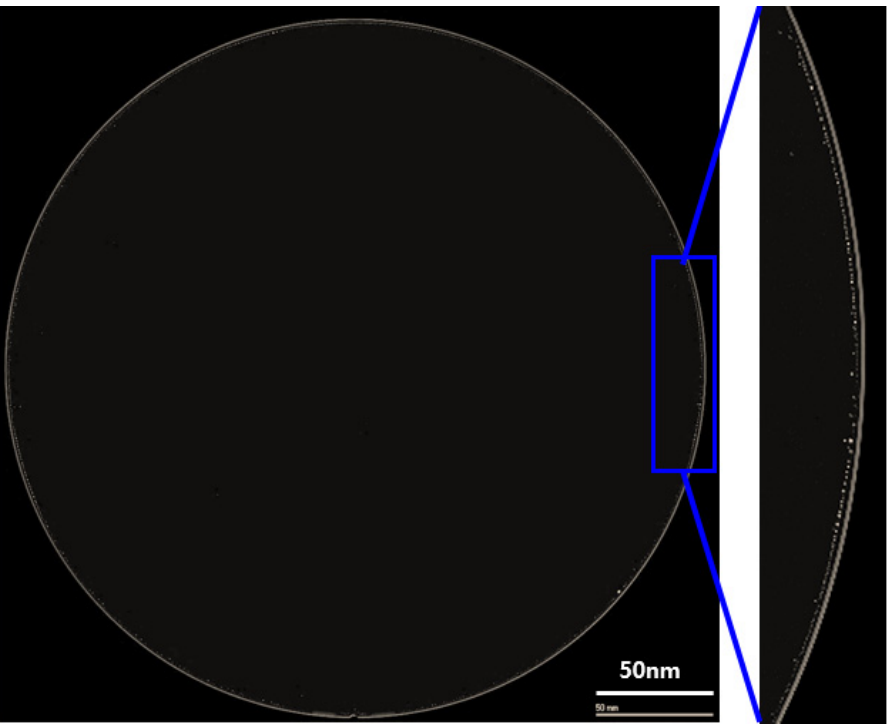
Figure 4. The top image of the bonded wafer using a c-SAM and edge void image shown in the yellow circles.